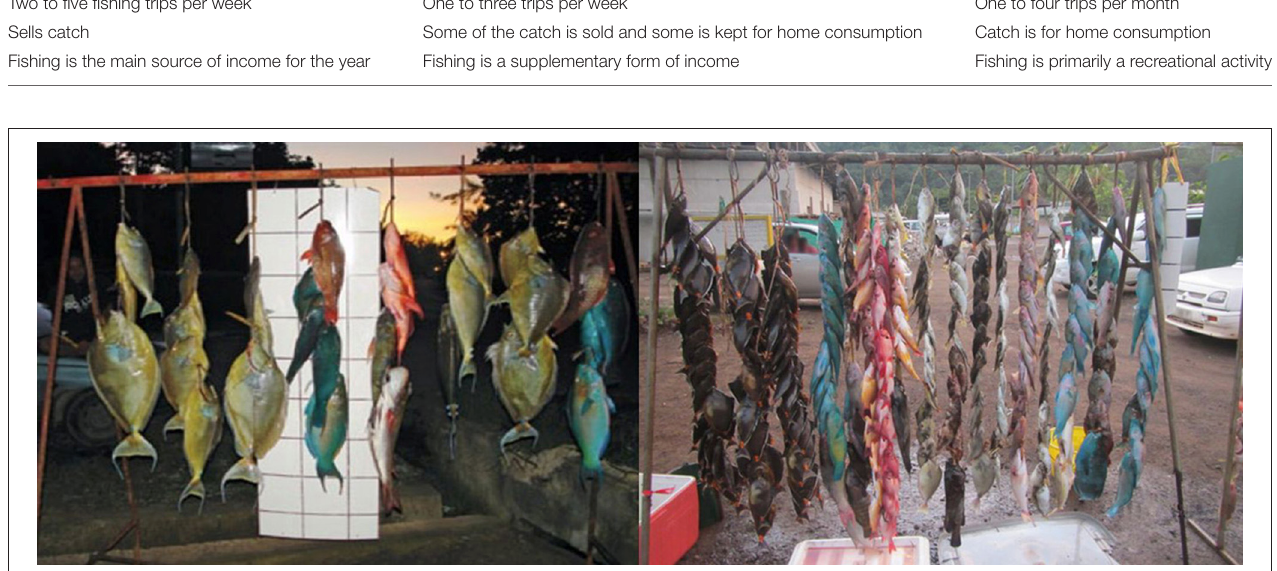
FIGURE 1 | Reef fish sold along the roadside on Moorea. Boards in background are used by scientists to estimate sizes (Images: R. Madi